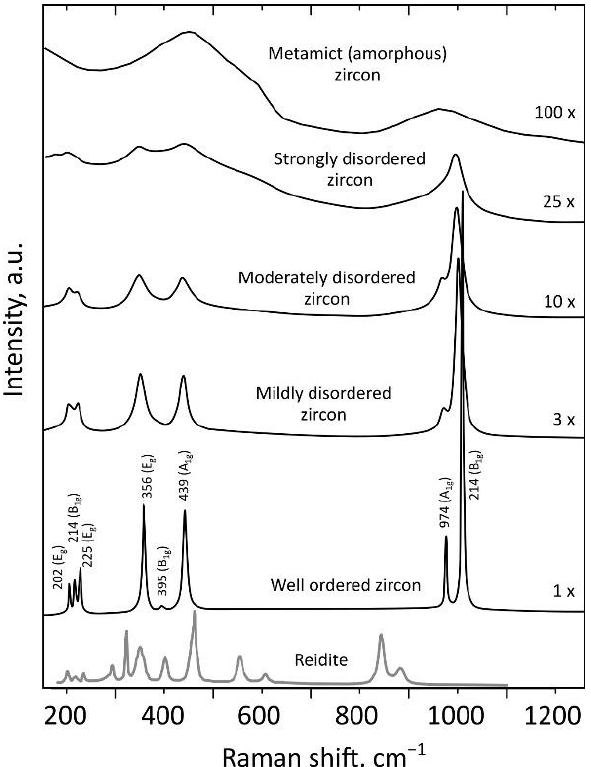
Figure 3. Raman spectra in zircon with various degrees of radiation damage (structure disorder) and high-pressure polymorph reidite. Modified after [9,56].